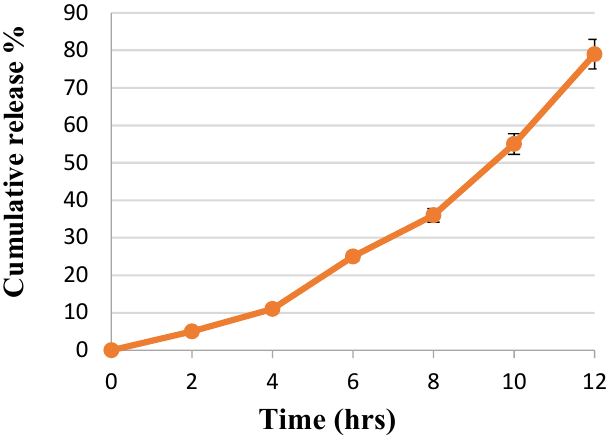
Figure 5. Rate of release of Amoxicillin from the synthesized nSE/P/Amoxicillin.